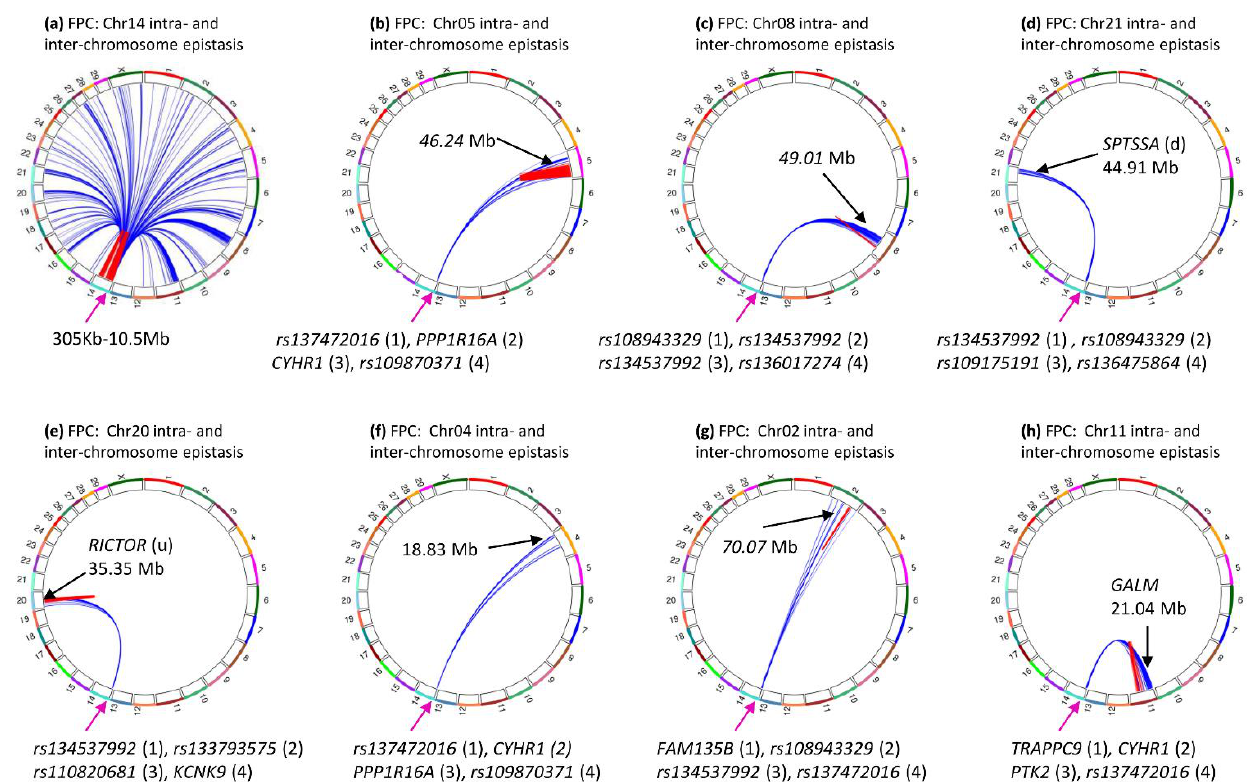
Figure 8. Examples of inter-chromosome epistasis effects between the same Chr14 region and different chromosomes for fat percentage (log10(1/p) ≥ 12.82). Each number on the outer circle is the chromosome number, red color represents intra-chromosome epistasis effects, and blue color represents inter-chromosome epistasis effects. Number in () is the effect ranking. The arrow indicates the Chr14 region that interacted with every chromosome for fat percentage. FPC = fat percentage. ( a ): Inter-chromosome epistasis effects between 26 chromosomes and the 0.3-10.5 Mb region of Chr14 for fat percentage. ( b ): Inter-chromosome epistasis effects between Chr05 and the 0.3-10.5 Mb region of Chr14 for fat percentage. ( c ): Inter-chromosome epistasis effects between Chr08 and the 0.3-10.5 Mb region of Chr14 for fat percentage. ( d ): Inter-chromosome epistasis effects between Chr21 and the 0.3-10.5 Mb region of Chr14 for fat percentage. ( e ): Inter-chromosome epistasis effects between Chr20 and the 0.3-10.5 Mb region of Chr14 for fat percentage. ( f ): Inter-chromosome epistasis effects between Chr04 and the 0.3-10.5 Mb region of Chr14 for fat percentage. ( g ): Inter-chromosome epistasis effects between Chr02 and the 0.3-10.5 Mb region of Chr14 for fat percentage. ( h ): Inter-chromosome epistasis effects between Chr11 and the 0.3-10.5 Mb region of Chr14 for fat percentage.